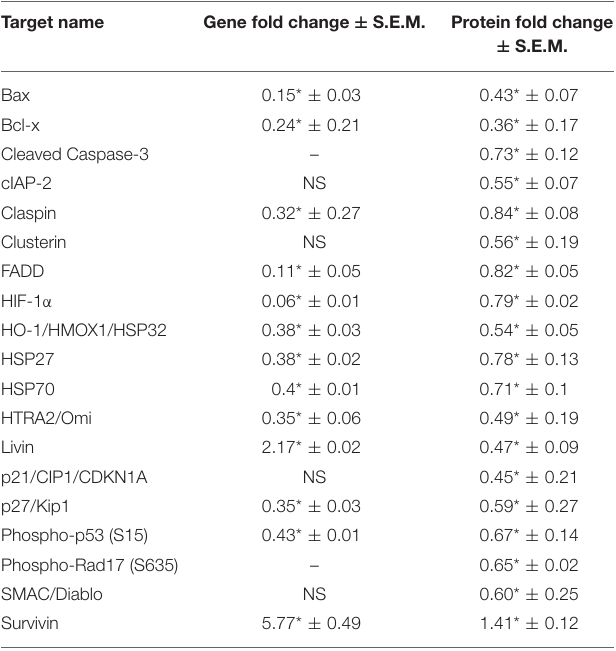
TABLE 3 | Fold regulation comparison for significant proteins within human p53 and apoptosis signaling and related pathways and their corresponding gene expression from the microarray data